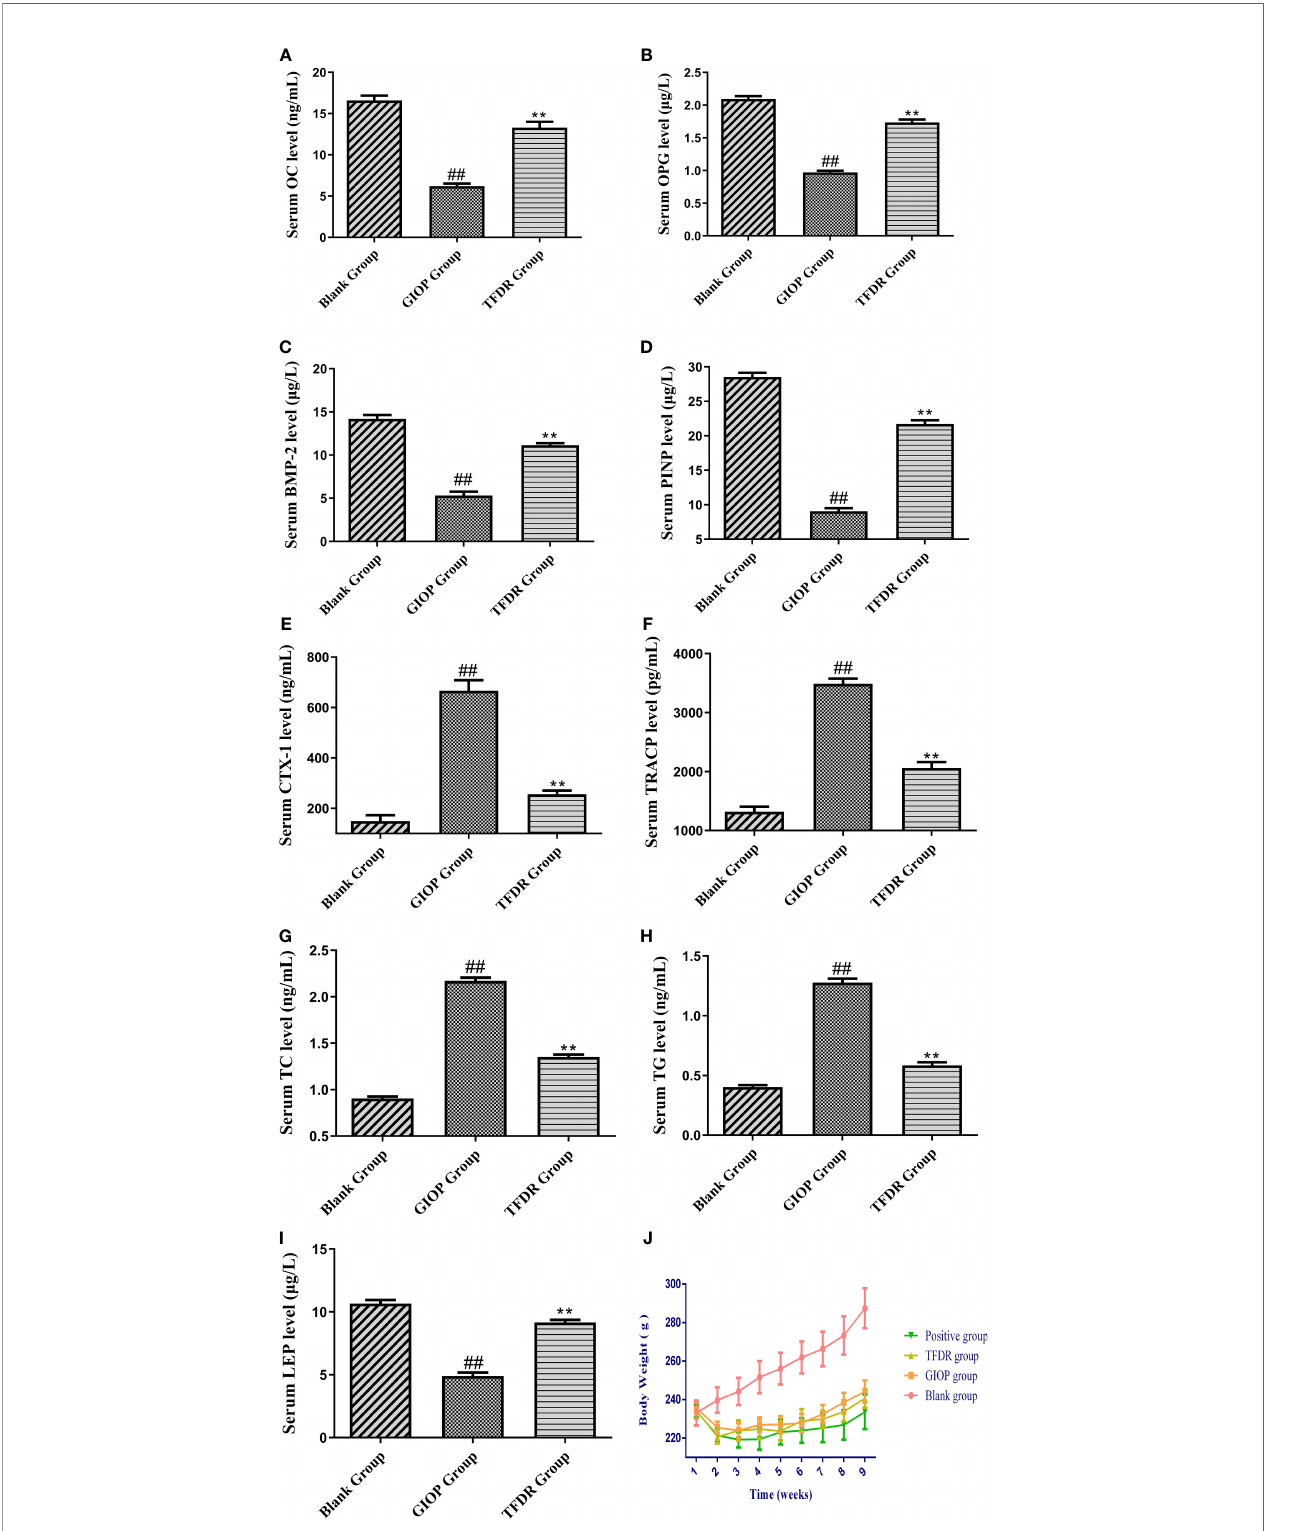
FIGURE 8 | The serum biochemical parameters including OC (A) , OPG (B) , BMP-2 (C) , PINP (D) , CTX-1 (E) , TRACP (F) , TC (G) , TG (H) , LEP (I) and the changes of body weight (J) . Data are expressed as mean ± SEM. *p < 0.05 and **p < 0.01 vs. GIOP group rats; # p < 0.05 and ## p < 0.01 vs. blank group rats (n =